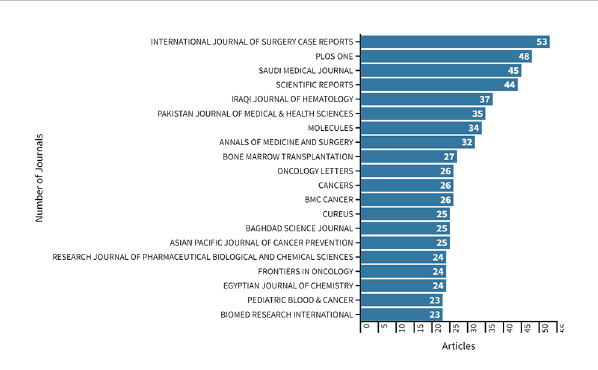
FIGURE 3 Top 20 most relevant sources by the number of publications on cancer research in FCS in the MENA region from 2000 to 2021.